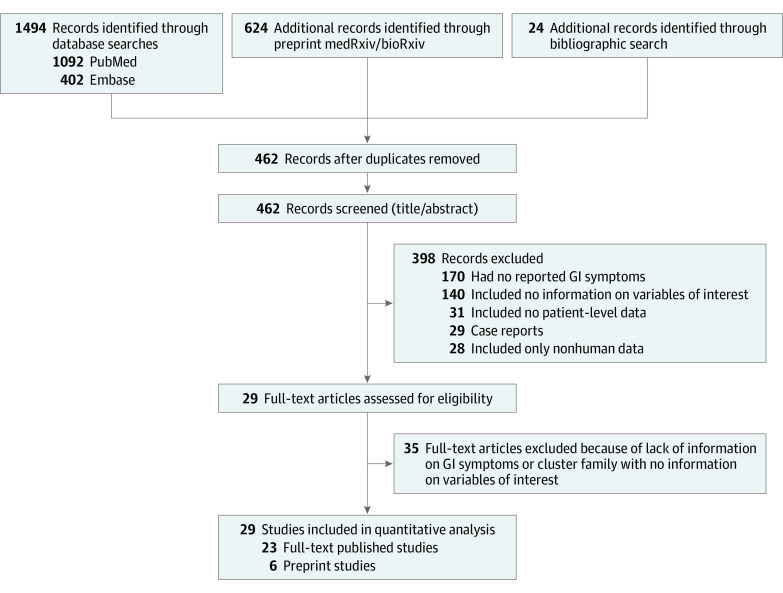
PRISMA Flow Diagram Depicting Study Selection ProcessGI indicates gastrointestinal.